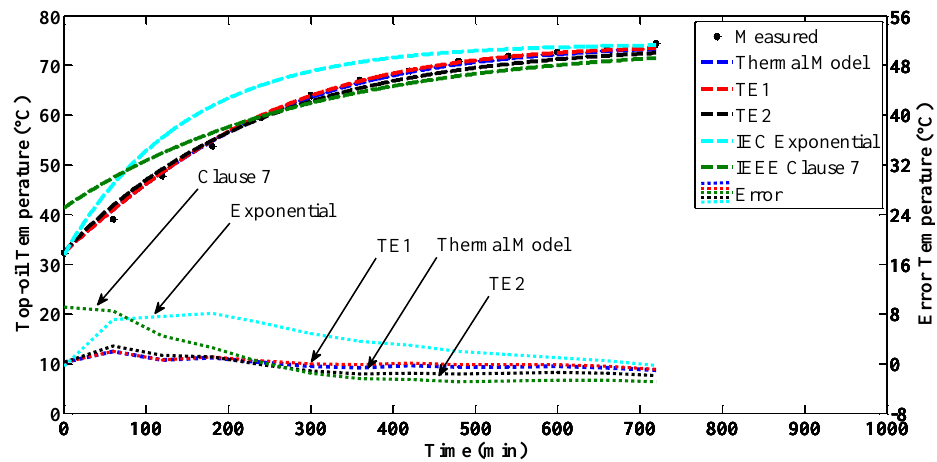
Figure 12. TOT based on different thermal models for TX6.